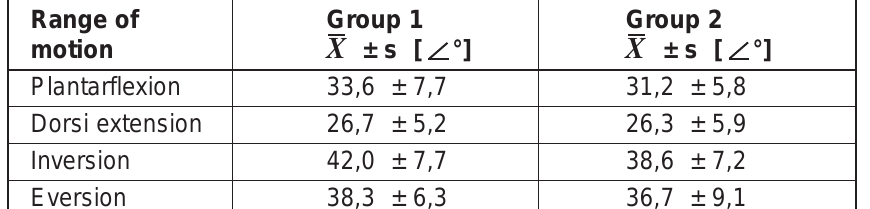
Table 1: Range of motion in the ankle joint in the comparison groups at the final examination (T2)